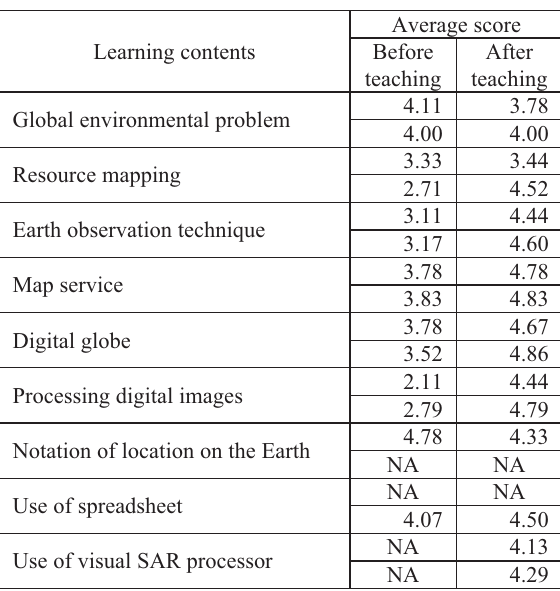
Table 2. Evaluation results. The upper and lower rows indicate the average scores of the first and second teaching practices,